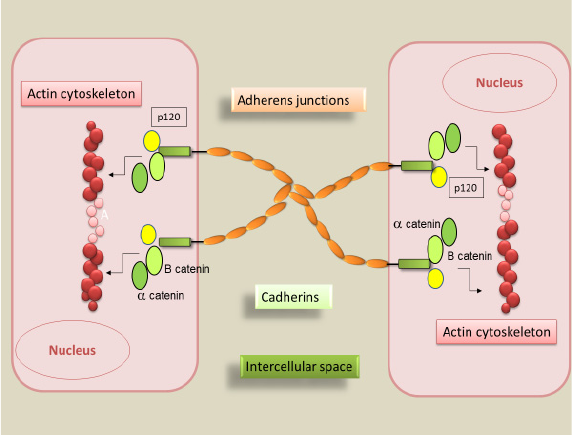
Figure 1. Schematic overview of the molecular components of adhesive intercellular junctions. In adherens junctions, the cadherin cytoplasmic domain binds to p120- α -catenin and β -catenin. The structure, composed of β -catenin, allows α -catenin to link this complex to the cellular actin cytoskeleton.